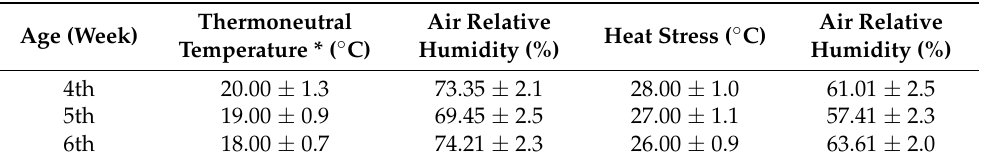
Table 2. The values of temperature ( ◦ C) and relative air humidity (%) that were used to stress the broilers at the fourth, fifth, and sixth weeks of